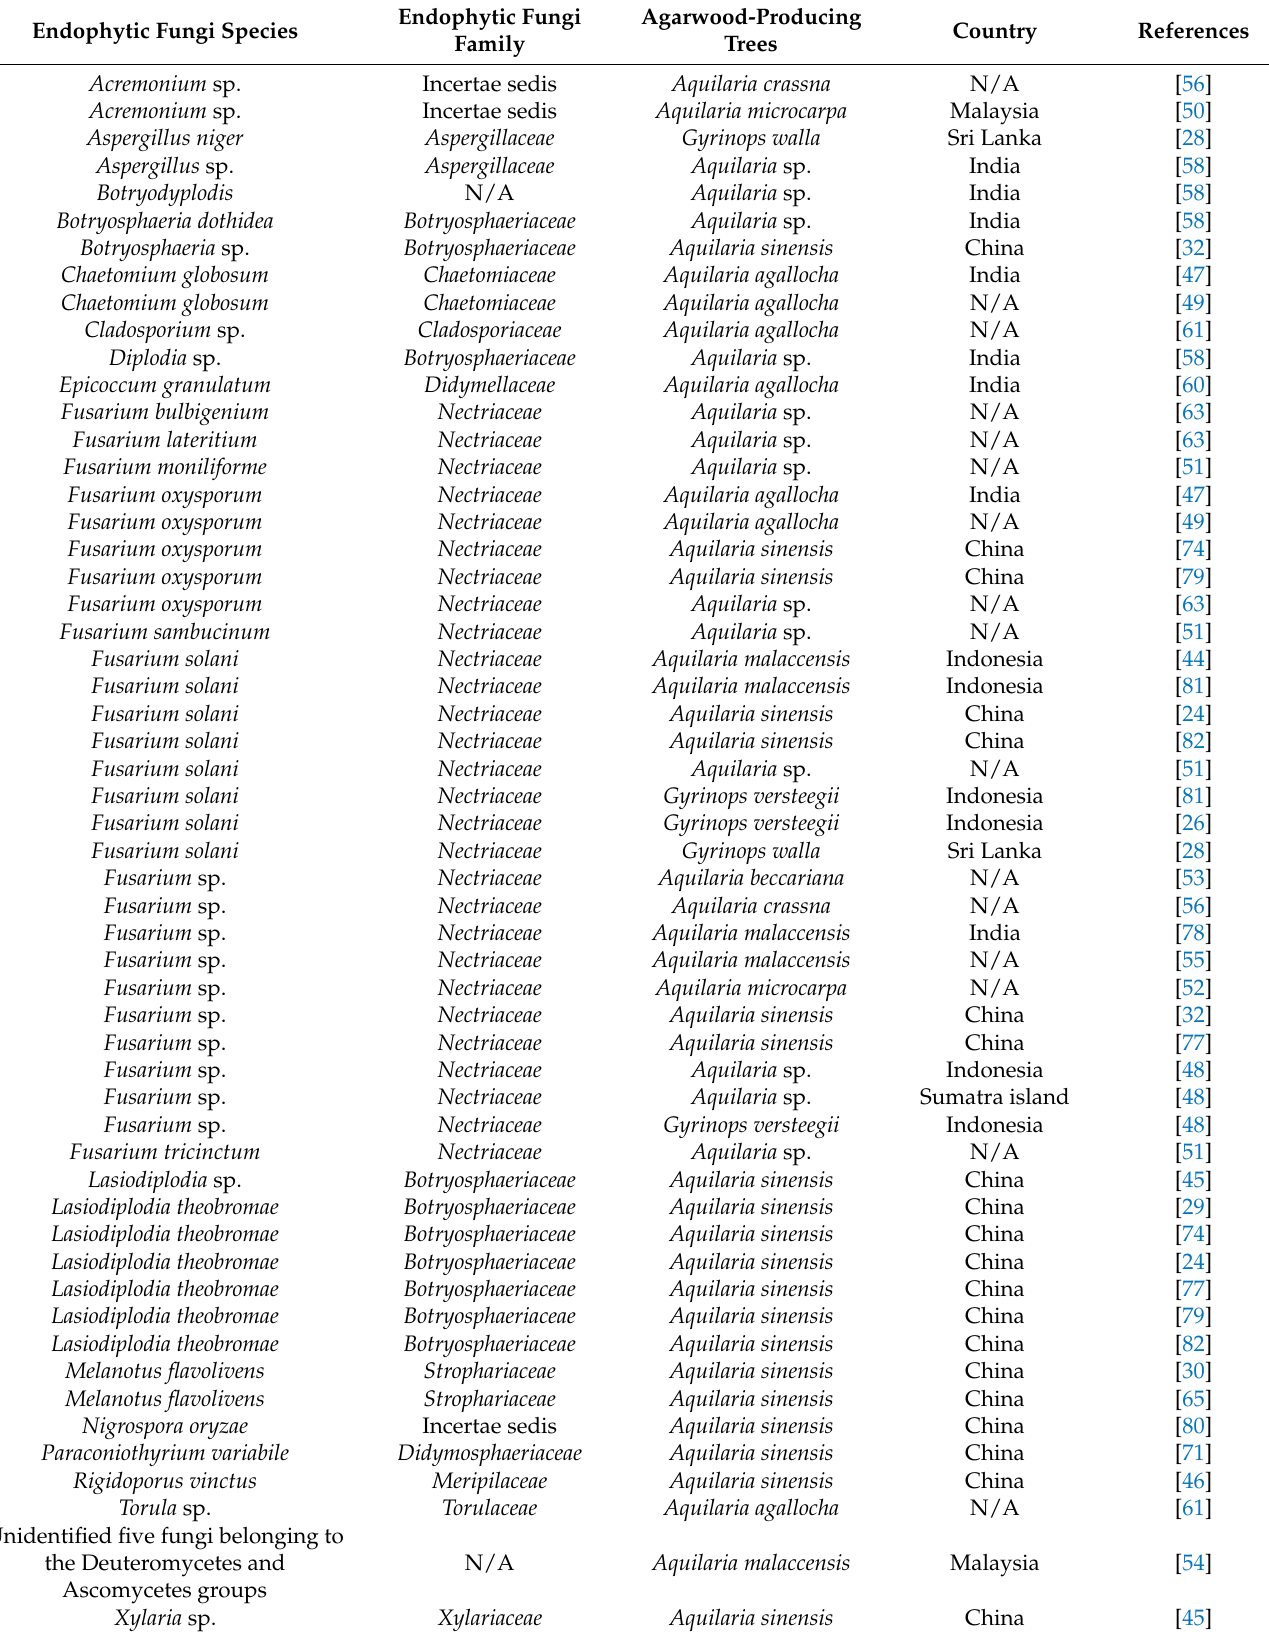
Table 2. Endophytic fungi that have been shown to induce the formation of agarwood. “N/A” indicates no information